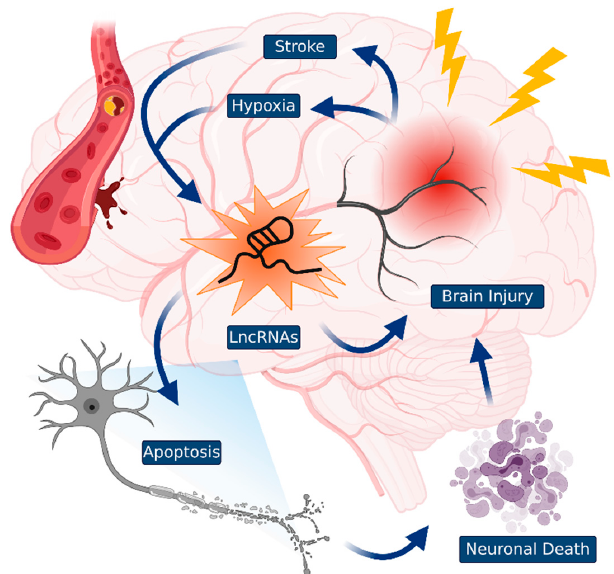
Figure 2. Traumatic brain injuries (TBIs) and lncRNAs. TBIs that occurred by diverse damage to the brain induces a cascade of neuronal cell death events. The specific lncRNAs control TBIs, such as stroke and hypoxia. Identification of novel lncRNAs could be useful as a guide to TBI diagnosis and may be used in the development of novel therapeutic targets.